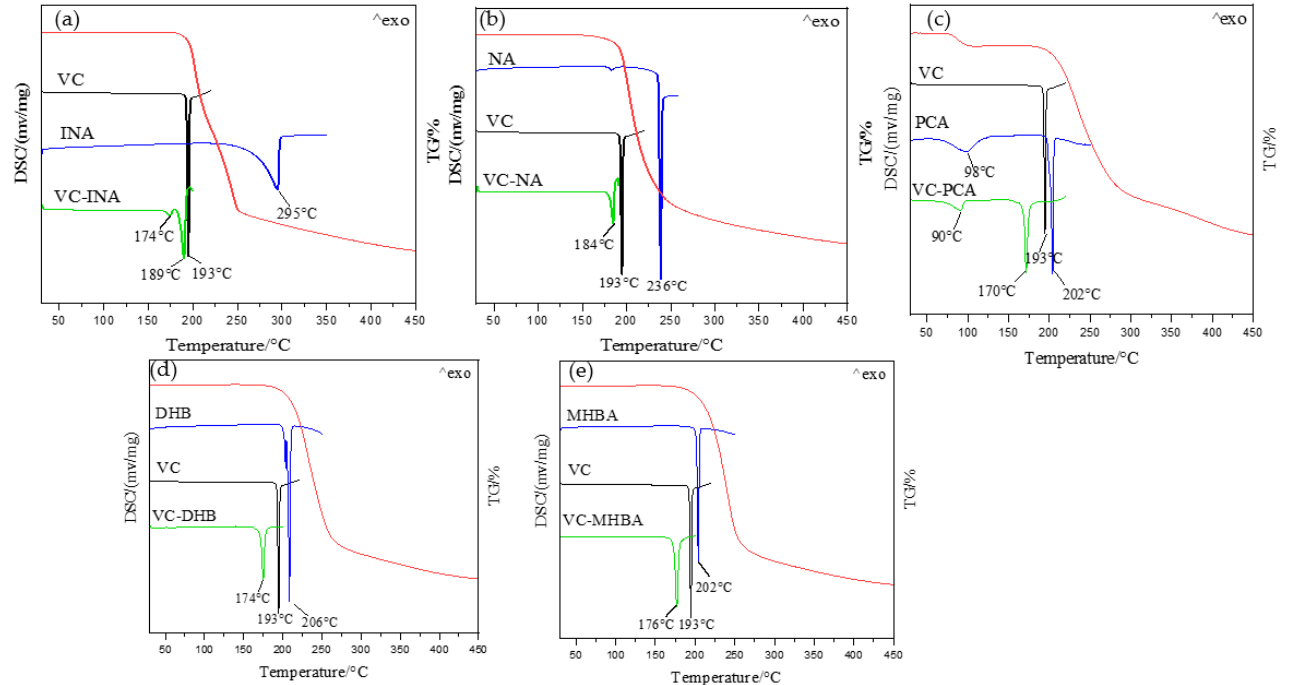
Figure 3. Schematic diagram of thermal analysis (( a ): DSC and TG images of VC-INA co-crystal; ( b ): DSC and TG images of VC-PCA co-crystal; ( c ): DSC and TG images of VC-NA co-crystal; ( d ): DSC and TG images of VC-DHB co-crystal; ( e ): DSC and TG images of the VC-MHBA co-crystal.).